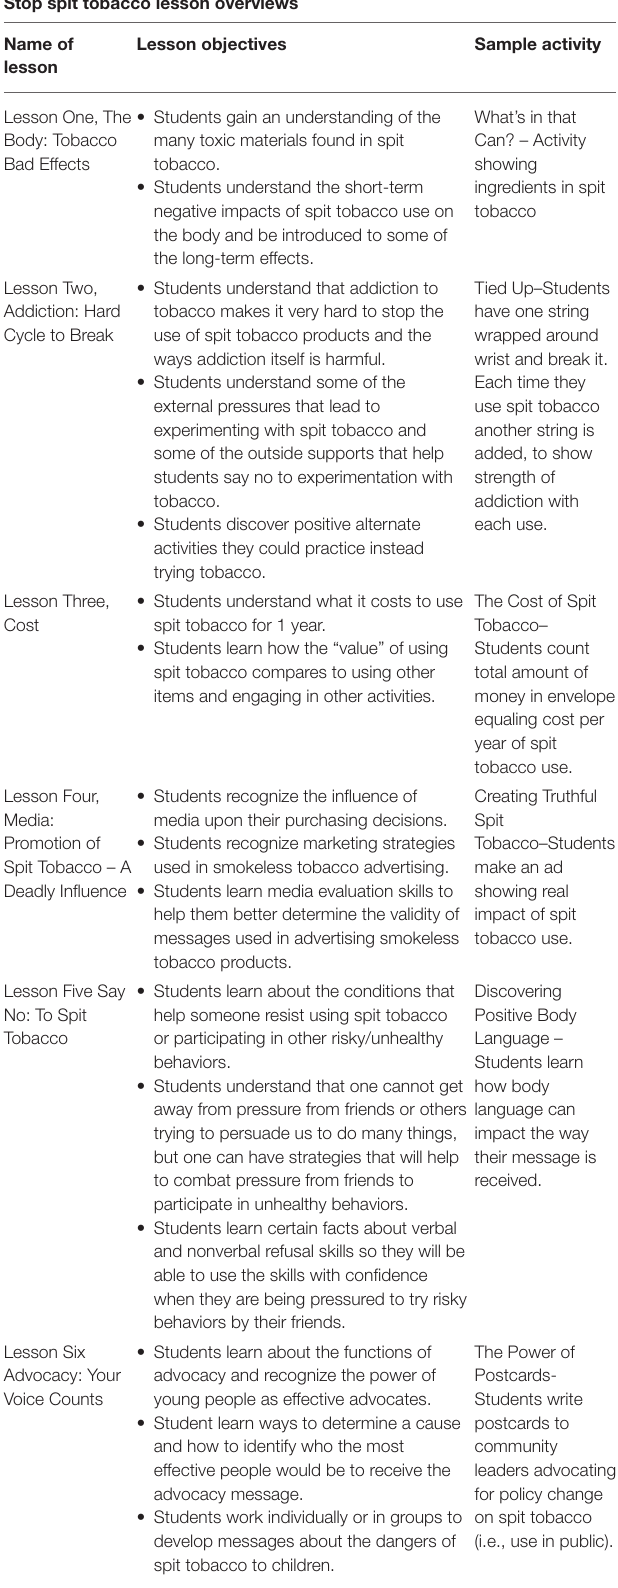
TABLE 1 | Curriculum